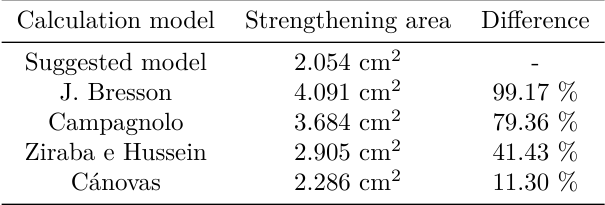
Table 2. Comparison of the calculated strengthening sheet